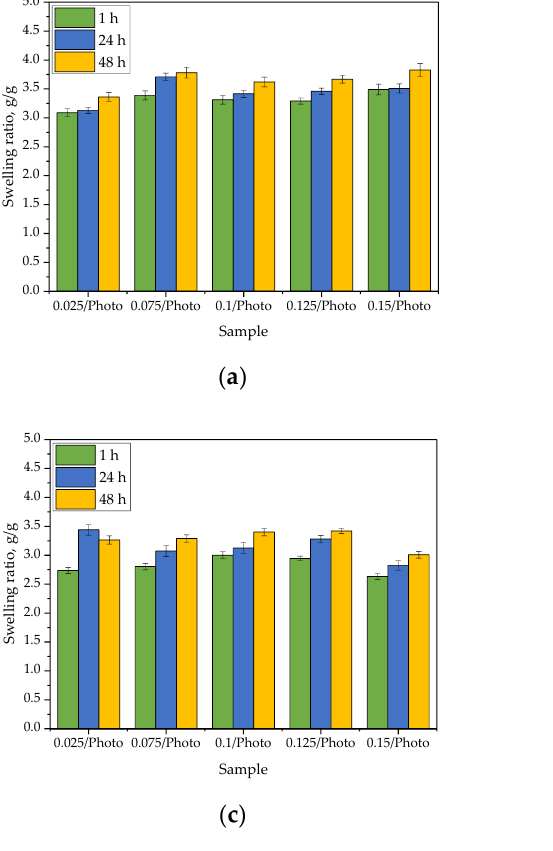
Figure 1. Results of the analysis of hydrogels’ sorption capacity in distilled water ( a ), SBF ( b ), Ringer liquid ( c ), and hemoglobin ( d ).